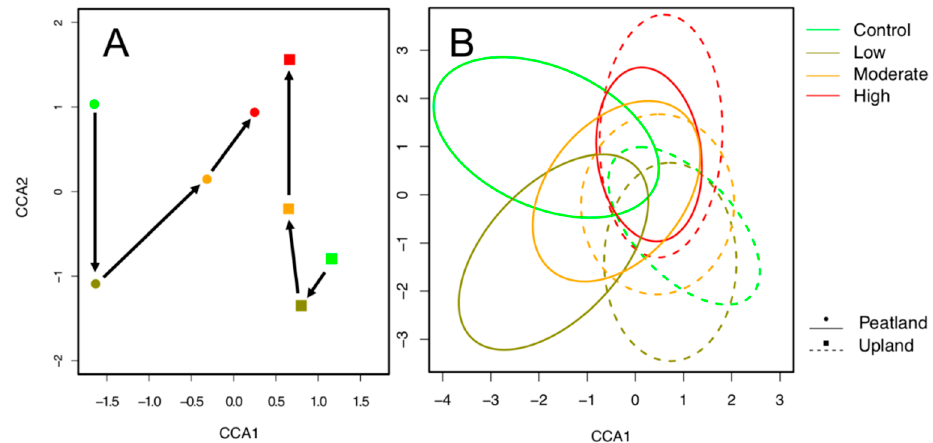
Figure 4. Partial canonical correspondence analysis (pCCA) ordination of bird communities in uplands and peatlands of increasing burn severity. Presented are ( A ) centroids of each treatment type (burn severity and vegetation types) joined by arrows indicating the direction of increasing burn severity for uplands (squares) and peatlands (circles); ( B ) 67% confidence ellipses around centroids (not shown) of each burn severity category.